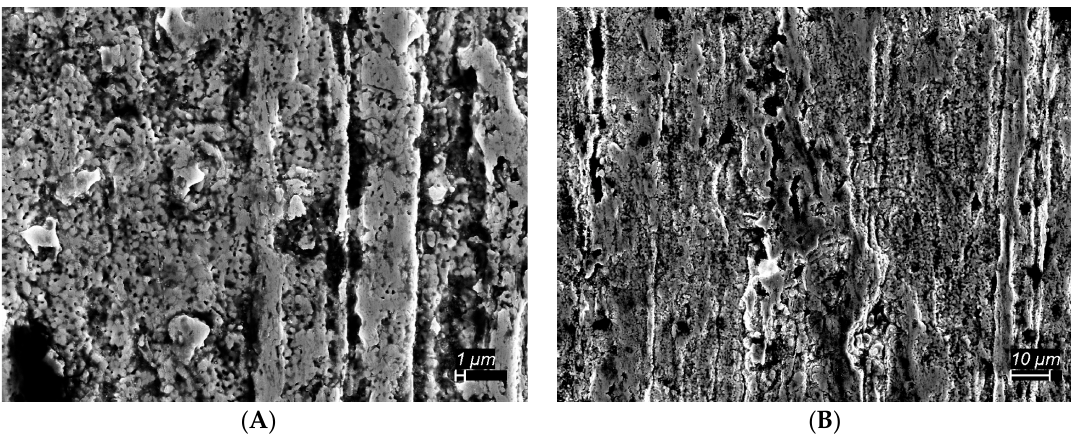
Figure 2. SEM Image Single Coat from Cr-Oxide Precursor. The image, collected 2 mm below the Fe/Cr interface, shows a chrome coat containing a significant number of pores of the order 1 micron in size. ( A ) On this scale ‘pores’ are clearly seen to be of scale 1 micron. ( B ) On this scale it is clear the coat is continuous, not a collection of particles.